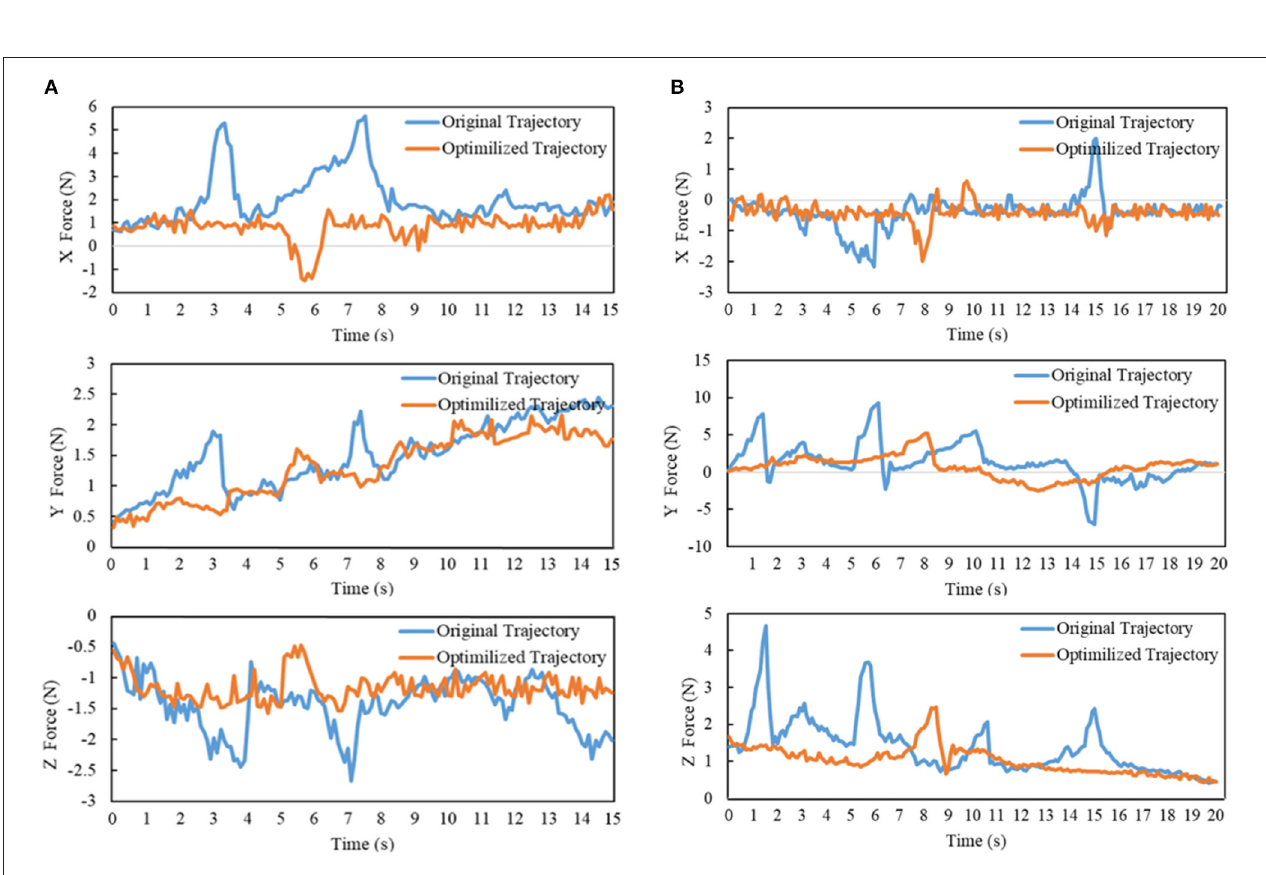
FIGURE 11 | (A) The force value of opening drawer process; (B) The force value of opening door process. The output force values in three directions of Force/Torque sensor after gravity compensation.